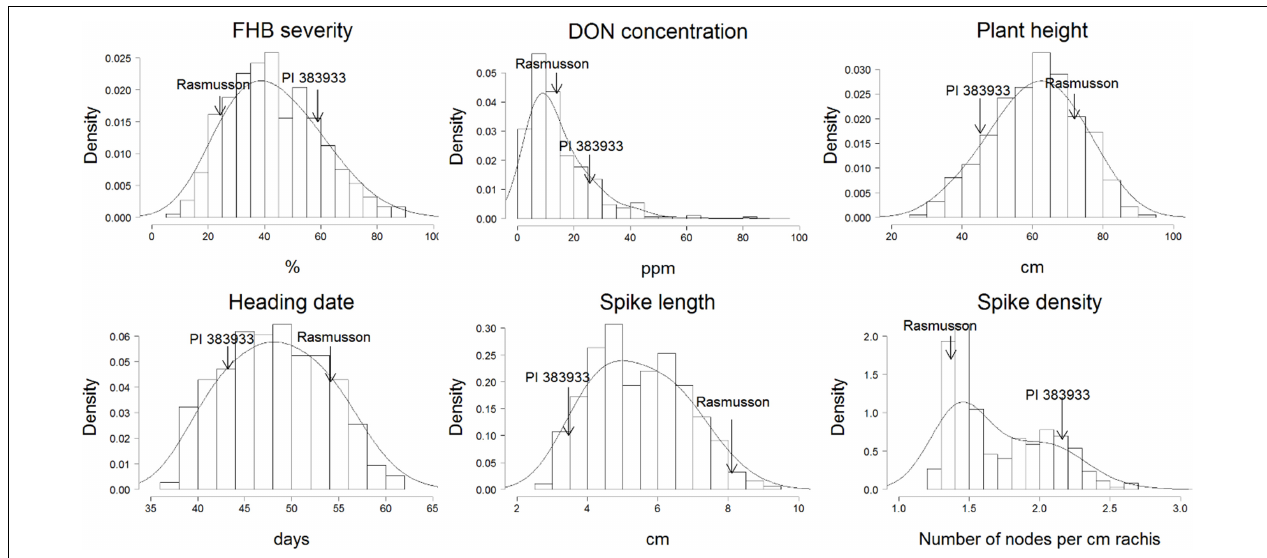
FIGURE 2 | Frequency distribution of trait observations in the Rasmusson × PI383933 recombinant inbred line (RIL) population. Values represented mean of each RIL within individual environment. Parental values for each trait were indicated by arrows. X -axis represents the unit of measurement. Y -axis represents the probability density estimation of the frequency of